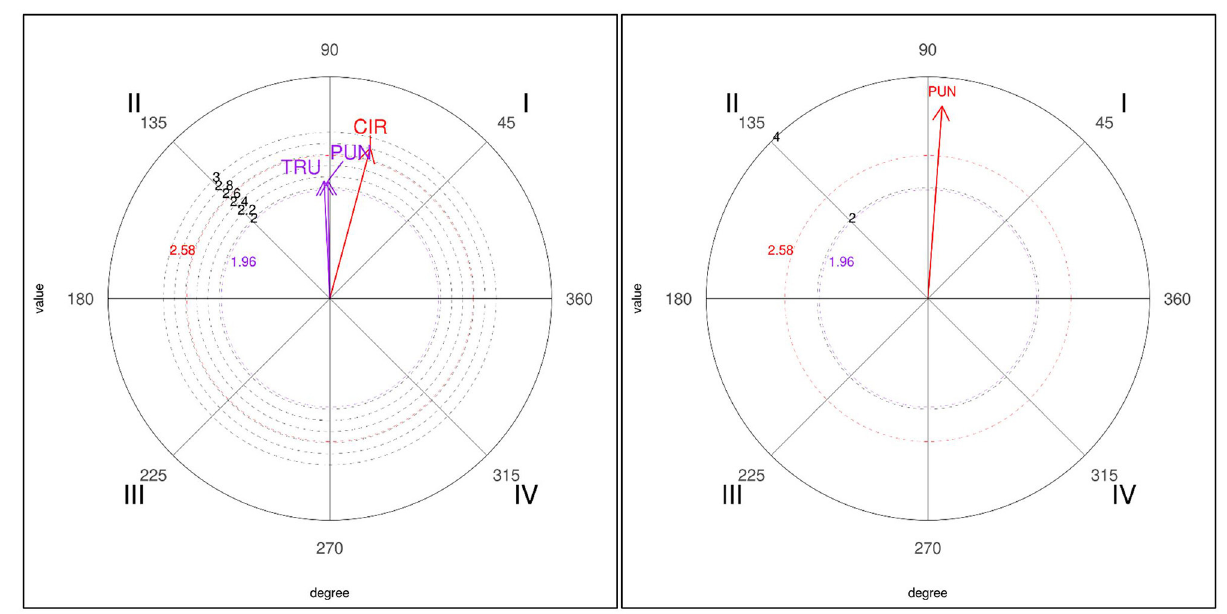
Frontiers in Sports and Active Living |